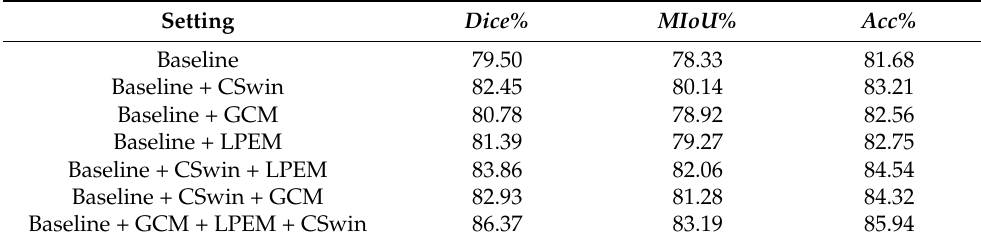
Table 1. Ablation Experiments on